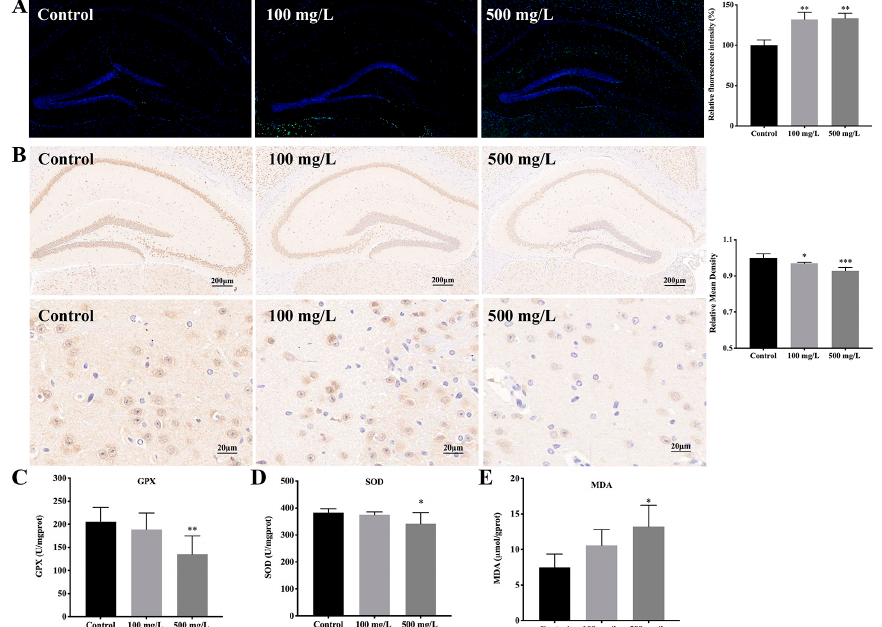
Figure 3. Cu induces oxidative damage and promotes apoptosis in mice hippocampal. ( A ) TUNEL staining of mice hippocampus after Cu exposure and relative fluorescence intensity of TUNEL-positive cells, green color indicates TUNEL-positive cells and blue indicates DAPI-stained nucleus, scale bar = 200 µm. ( B ) The effect of Cu exposure on the expression of NeuN and relative mean density of NeuN-positive cells. NeuN: neuron-specific nuclear proteins. Scale bar = 200 µm in first row in B, scale bar = 20 µm in second row in B. ( C – E ) GPX, SOD and MDA levels in the brain of the mice. * p < 0.05, ** p < 0.01, *** p < 0.001.